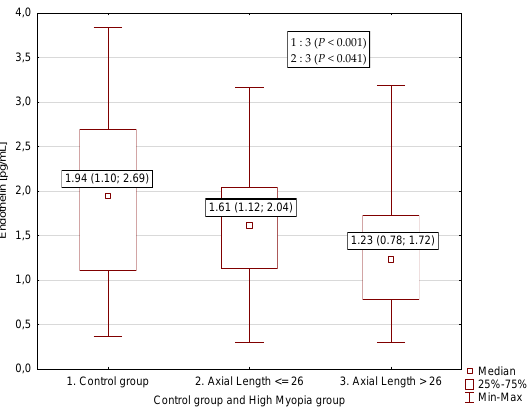
Figure 1. Endothelin-1 concentrations in myopic patients with the axial length of the eye > 26 and ≤ 26 mm and controls.